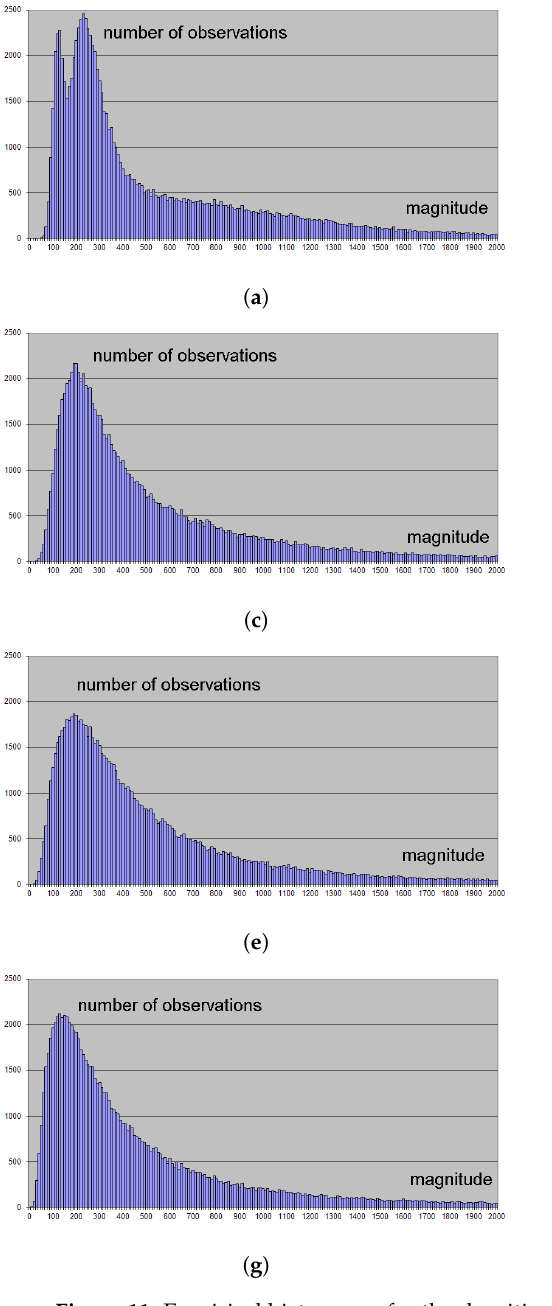
Figure 11. Empirical histograms for the densities of the aggregated risk in Example 3. ( a ) Bernstein copula, grid type 34 34. ( b ) Bernstein copula, grid type 10 10. ( c ) Bernstein copula, grid ˆ ˆ type 5 5. ( d ) Bernstein copula, grid type 4 4. ( e ) Gaussian copula. ( f ) Independence copula. ˆ ˆ ( g ) Comonotonicity copula. ( h ) Countermonotonicity